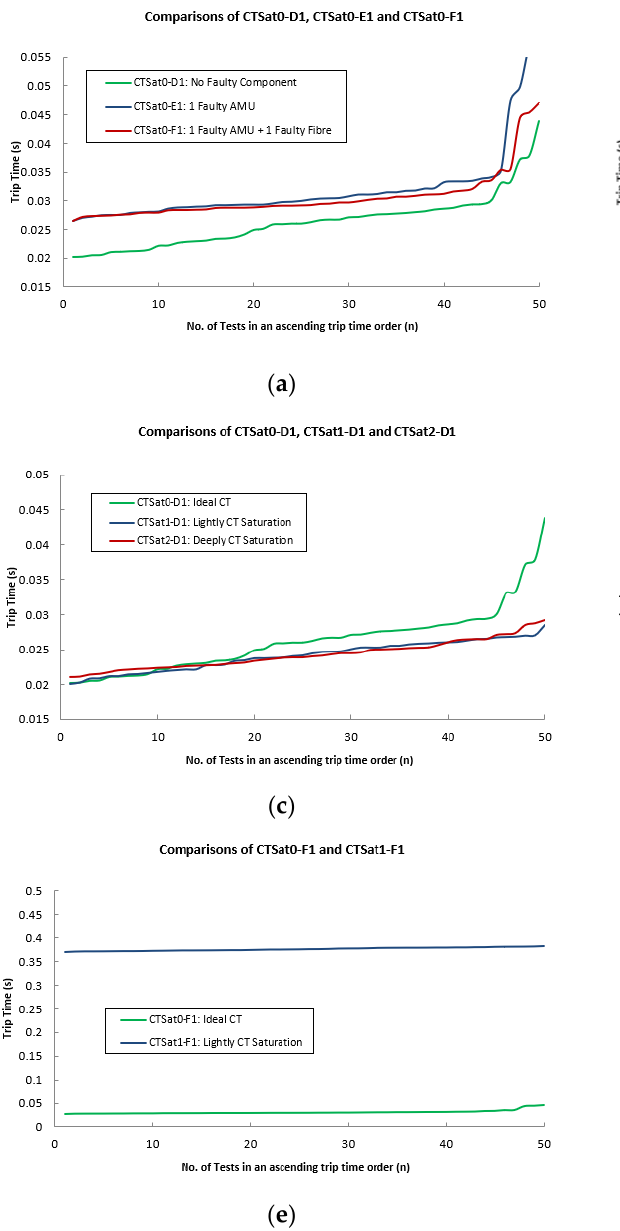
Figure 32. Comparisons: ( a ) CTSat0-D1, CTSat0-E1 and CTSat0-F1 (ideal CT, 3Ph-G fault at 50% of the feeder); ( b ) CTSat1-D1, CTSat1-E1 and CTSat1-F1 (light CT saturation, 3Ph-G fault at 50% of the feeder); ( c ) CTSat0-D1, CTSat1-D1 and CTSat2-D1 (situations with different levels of CT, no faulty component, 3Ph-G fault at 50% of the feeder); ( d ) comparisons for CTSat0-E1 and CTSat1-E1 (situations with different levels of CT, 1 faulty AMU, 3Ph-G fault at 50% of the feeder); and ( e ) CTSat0-F1 and CTSat1-F1 (situations with different levels of CT, 1 faulty AMU +1 faulty fibre, 3Ph-G fault at 50% of the feeder). Table 13. Mean trip times obtained for CT saturation tests for 3-phase-to-ground faults. Saturation